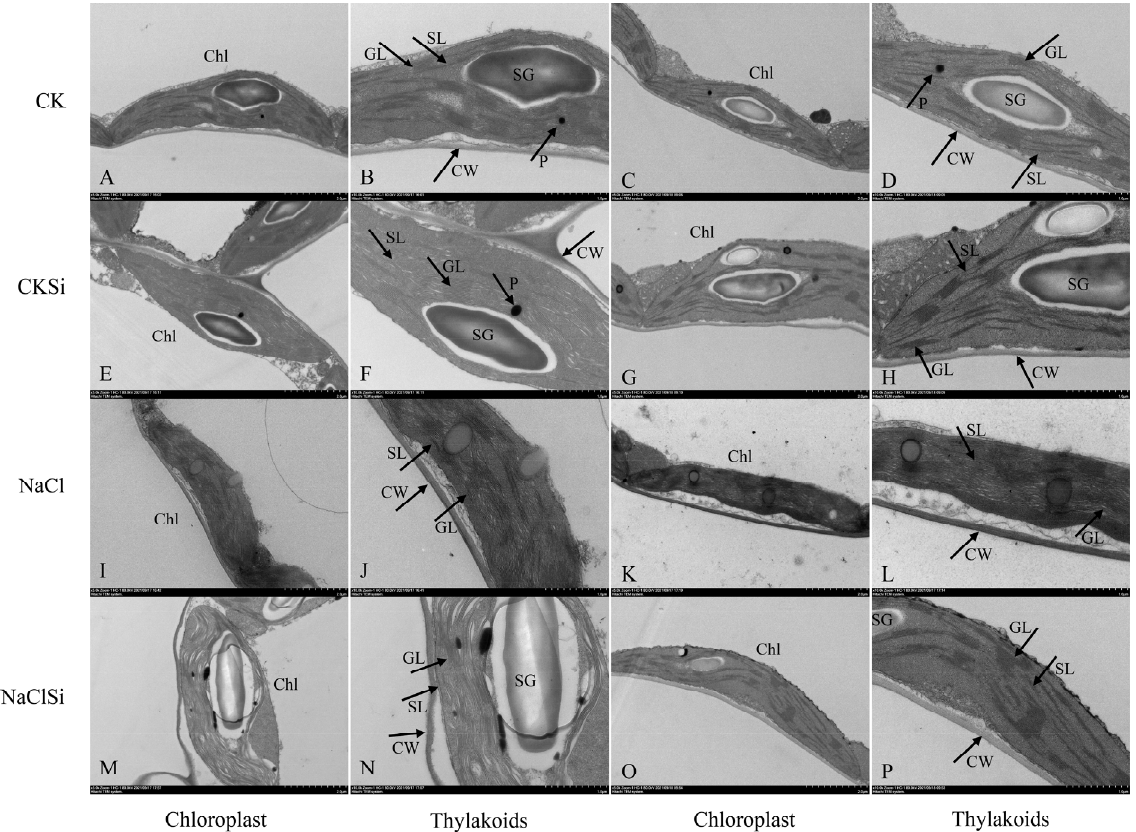
Figure 7. ( A – P ) Effect of exogenous Si on the ultrastructure of chloroplasts and thylakoid membranes of Z9807 and Z0102 leaves under saline and non-saline conditions. Scale bars: 2.0 µm (chloroplast); 1.0 µm (Thylakoids); Chl, Chloroplast; CW, cell wall; GL, Grana lamellae; SL, Stroma lamellae; SG, Starch grain; P, Plastoglobule.